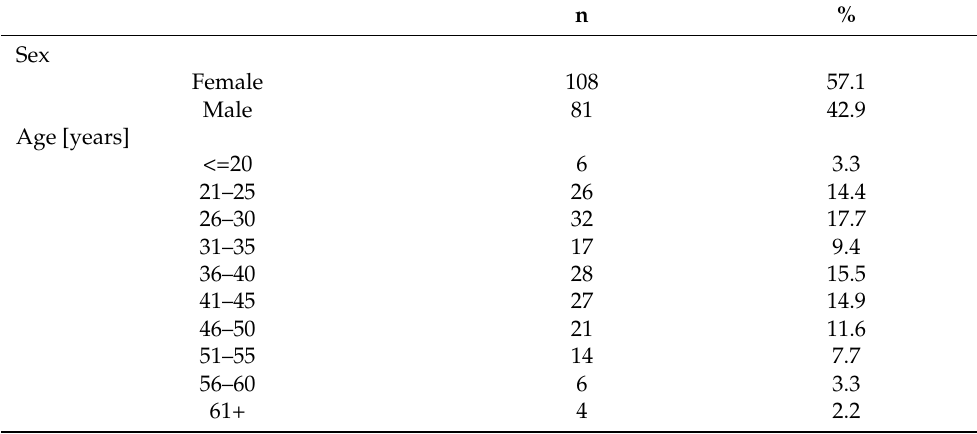
Table 1. Sociodemographic characteristics of the study